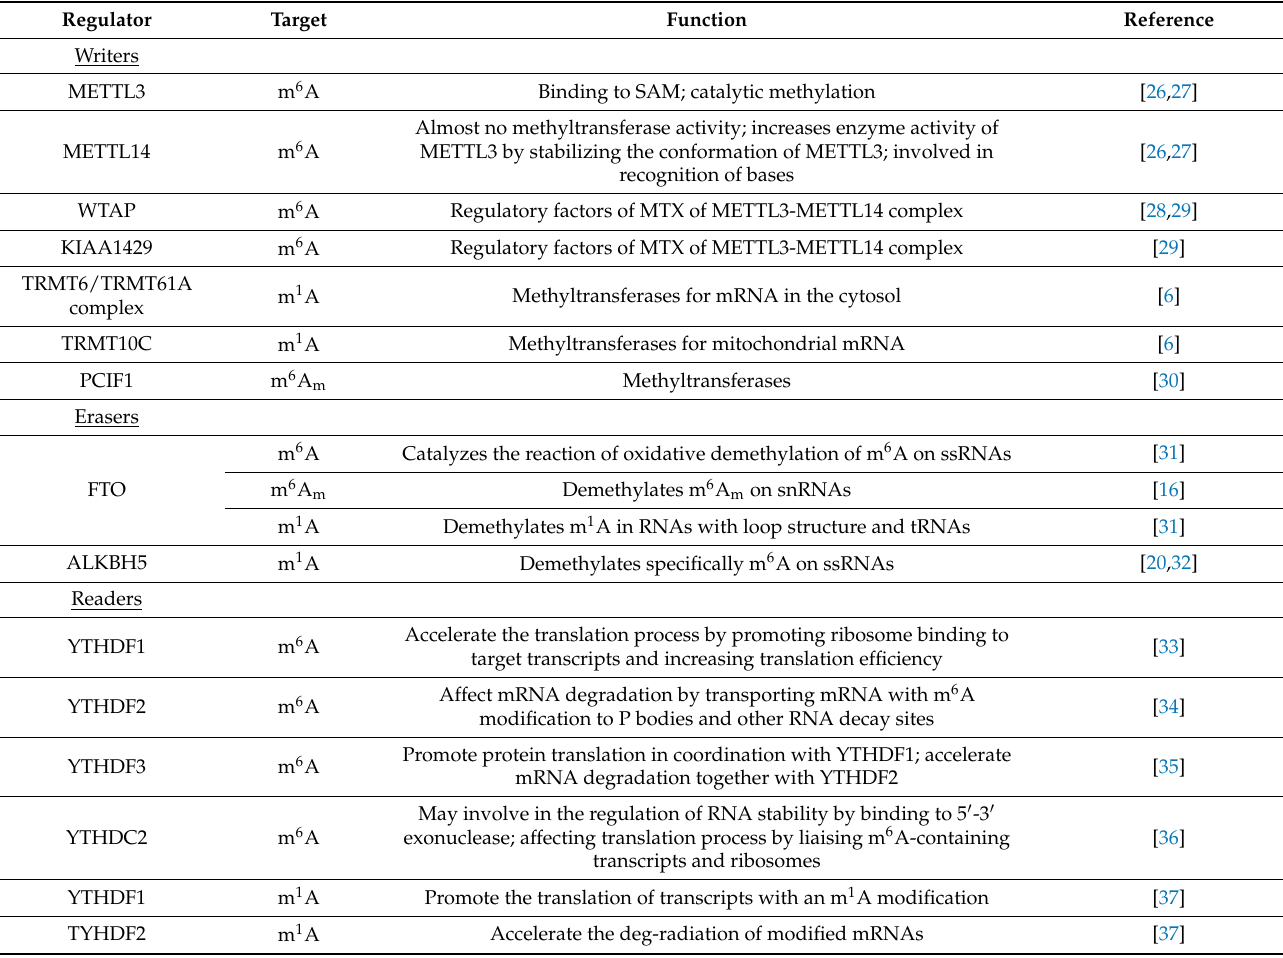
Table 1. The functions of m 6 A-related